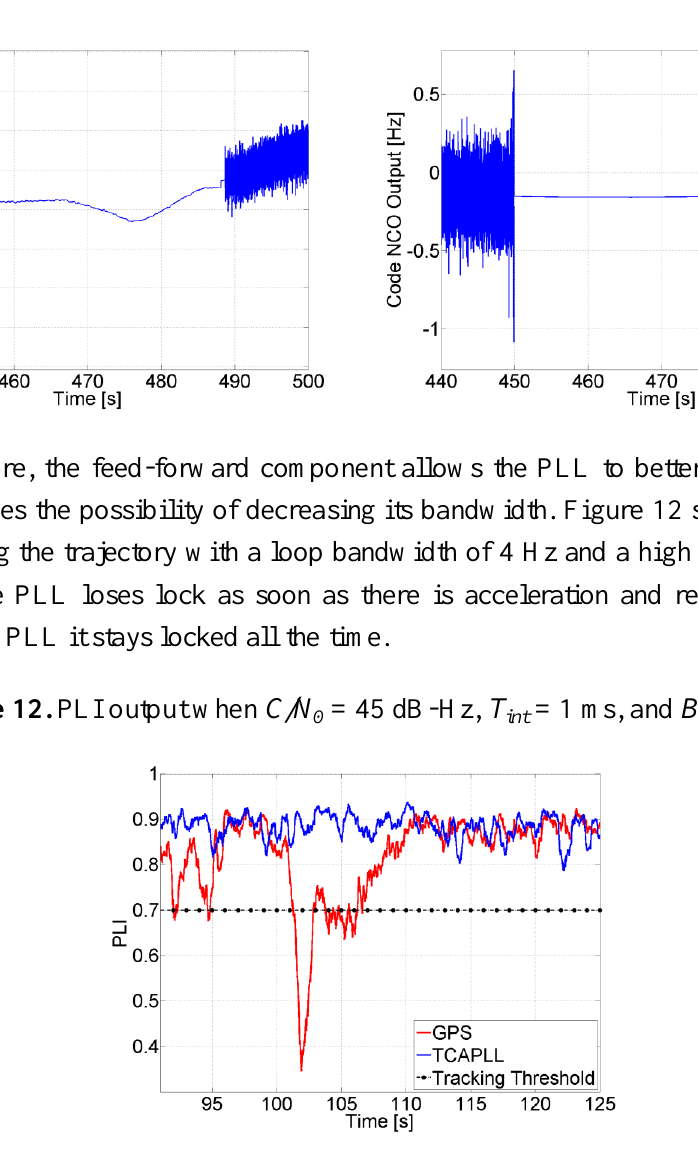
Figure 11. Carrier and code NCOs‘ behavior during GPS